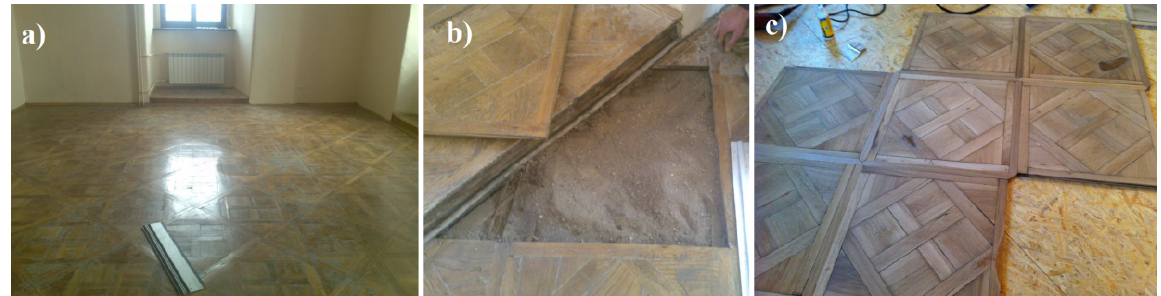
Figure 1: a) Palace floor in the monastery building in Kalwaria Zebrzydowska before renovation; b) The local excavation; c) Matching individ- ual elements of the sheet